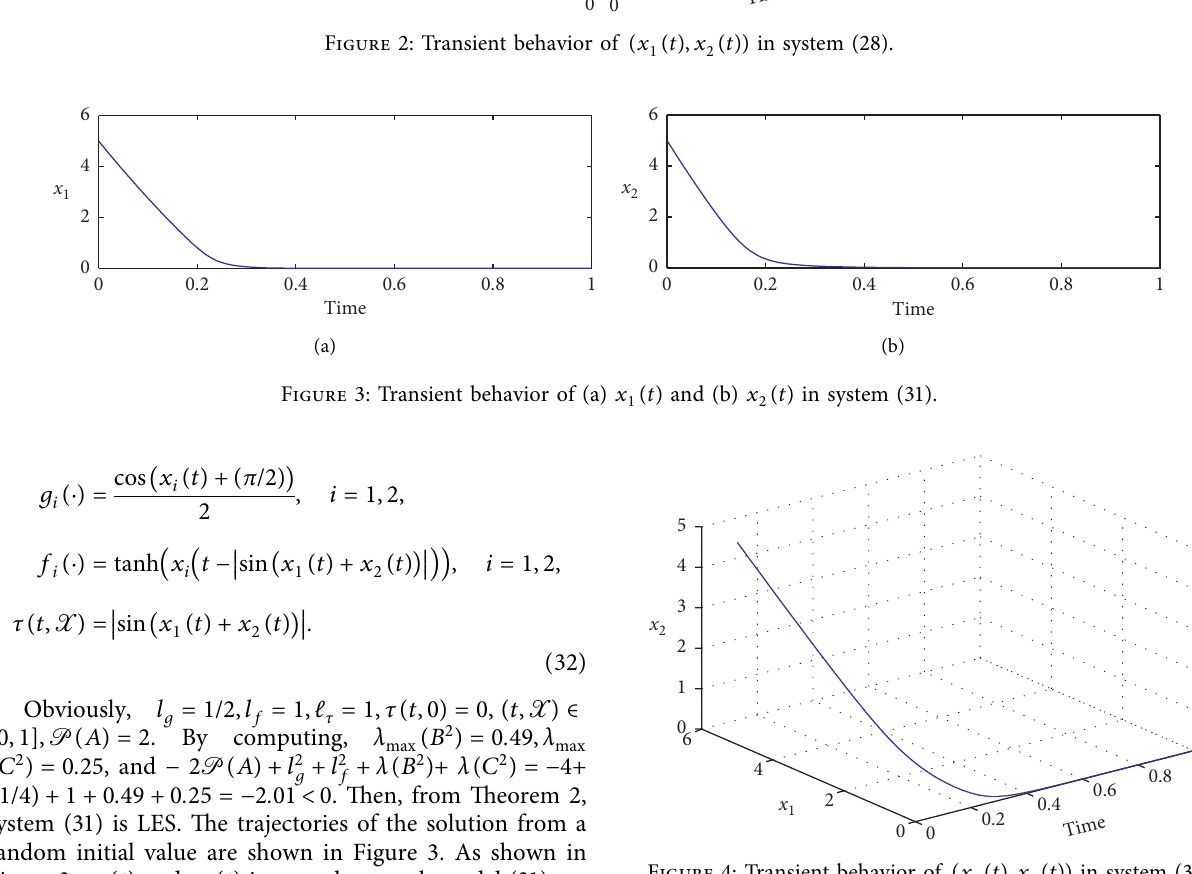
( t ) , x ( t )) in system 1 2